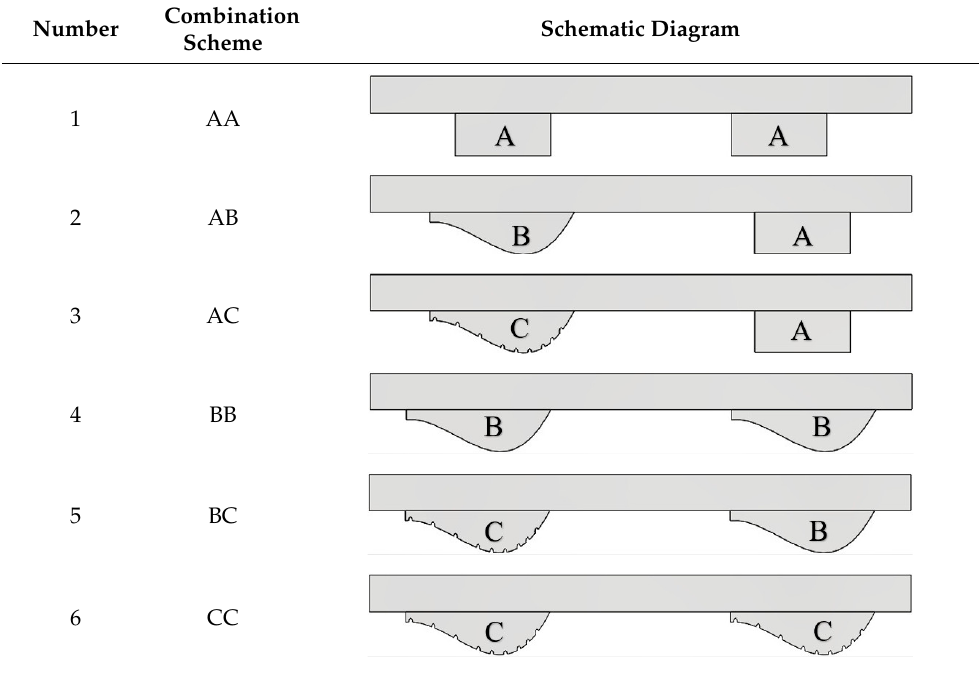
Table 2. Combination scheme of track shoe pattern.